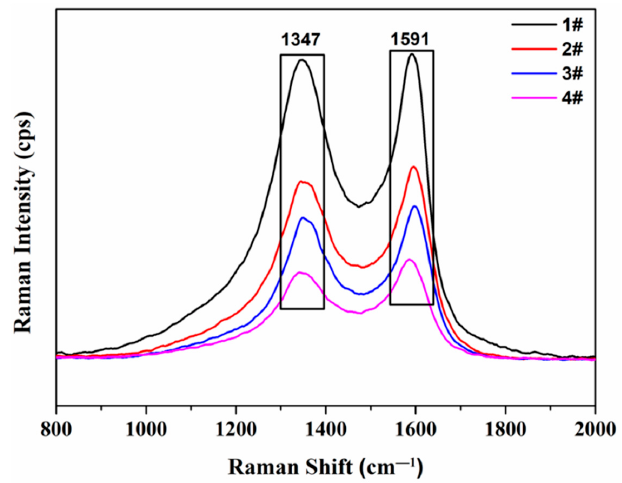
Figure 6. Raman spectra of each carbonaceous deposit layer in the coking chamber.